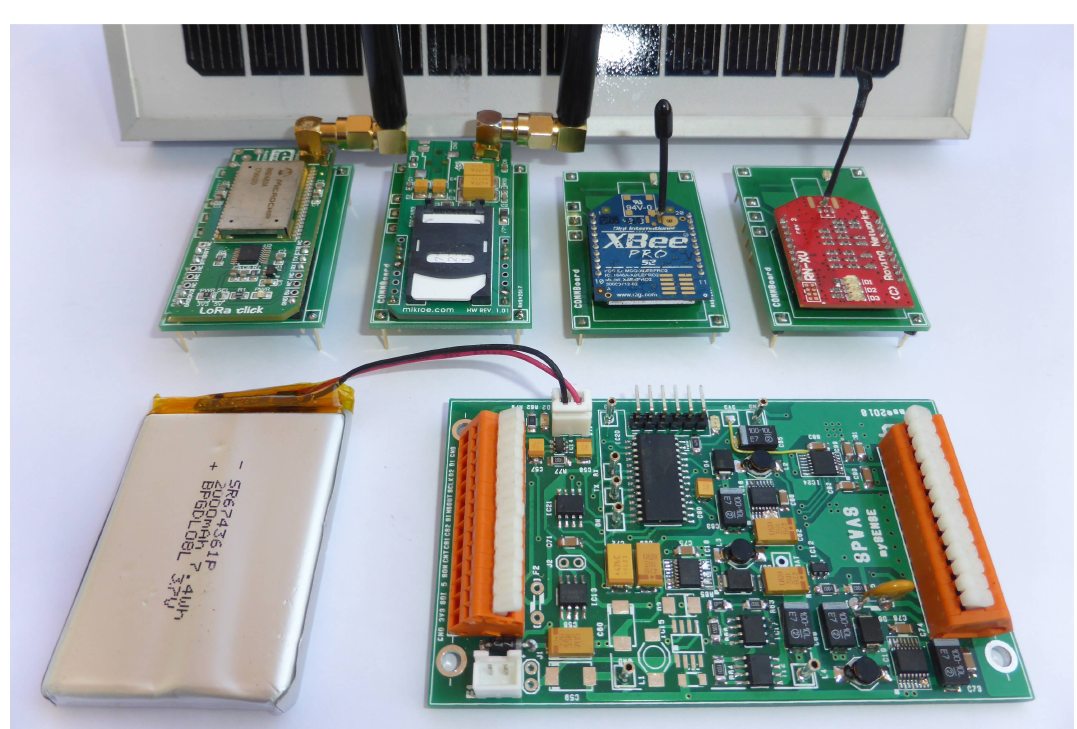
Figure 3. SPWAS’21 broad range of IoT